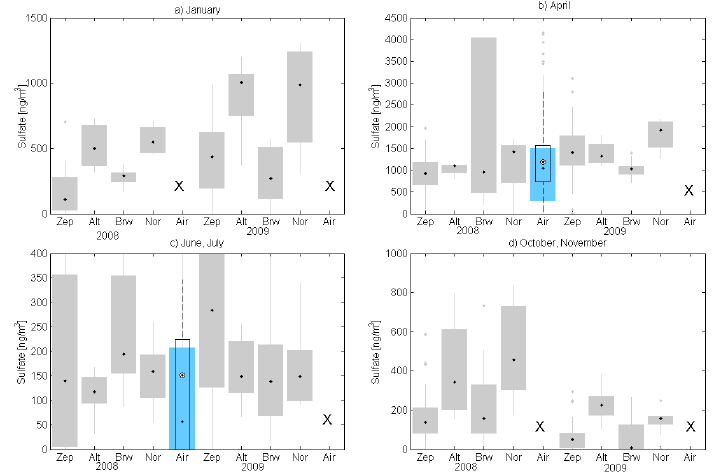
Figure 12. Same as Fig. 9 but for sulfate.